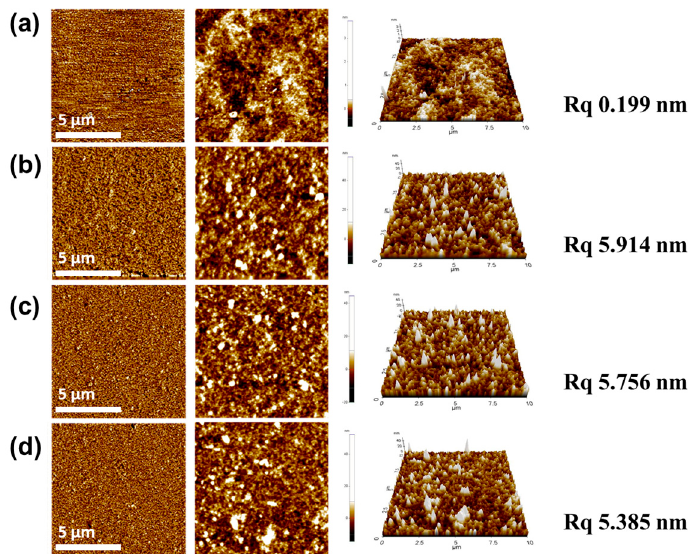
Figure 5. Atomic force microscopy (AFM) topographic ( left ), phase ( middle ), and 3D images ( right ) of ( a ) pristine PEDOT:PSS, ( b ) one-layered H-PEDOT:PSS, ( c ) two-layered H-PEDOT:PSS and ( d ) three-layered H-PEDOT:PSS thin films.